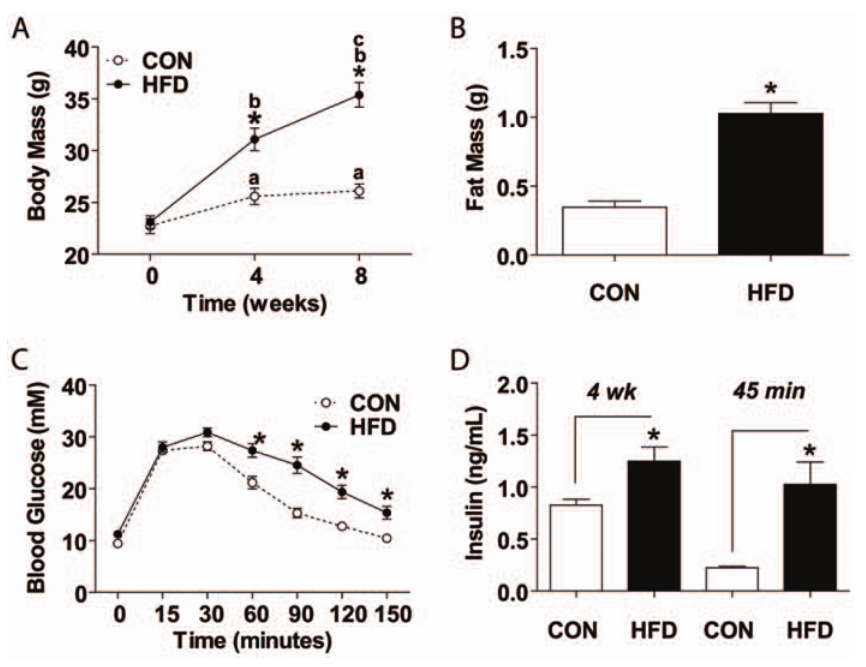
Figure 1. Eight weeks of a high fat diet (HFD) elicits pre-diabetes. (A) Fasted body mass was assessed before experimental diet began and after 4 and 8 weeks (N=19 CON, 20 HFD). (B) Epididymal fat mass after 8 weeks of diet intervention (N=19 CON, N=20 HFD). (C) Intraperitoneal glucose tolerance test (IPGTT) performed after an overnight fast (16 hrs) 1 week before harvest (N=19 CON, N=18 HFD). (D) Plasma insulin levels assessed 4 weeks into diet intervention (8 hr fast, N=10) and at IPGTT 45 minute time-point (16 hr fast, N=4). Significance is represented by * vs. CON at same time point (A–D), a or b vs. 0 weeks within diet group, and c vs. 4 weeks within diet group, p , 0.005.